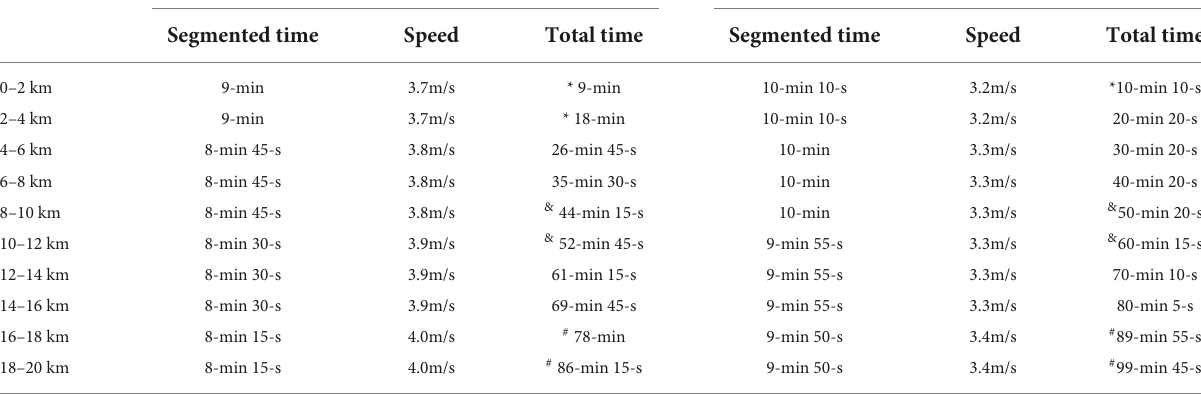
TABLE 1 The detailed time schedule of